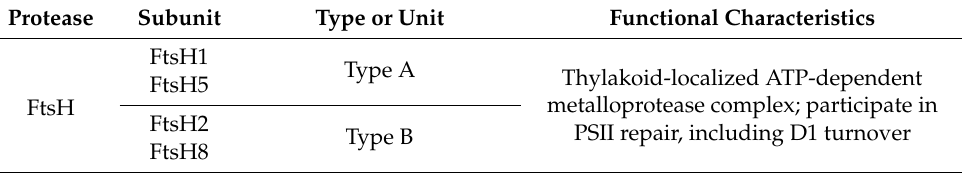
Table 1. Major chloroplast FtsH, Clp and Deg proteases in